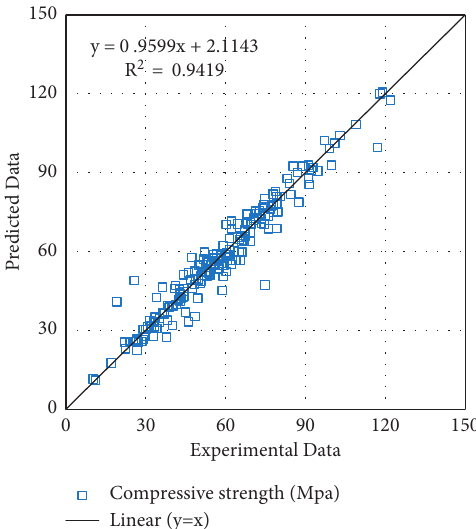
Figure 8: Experimental versus predicted values of SCC’s compressive strength for the ANN-GWO (7-13) model using all data.